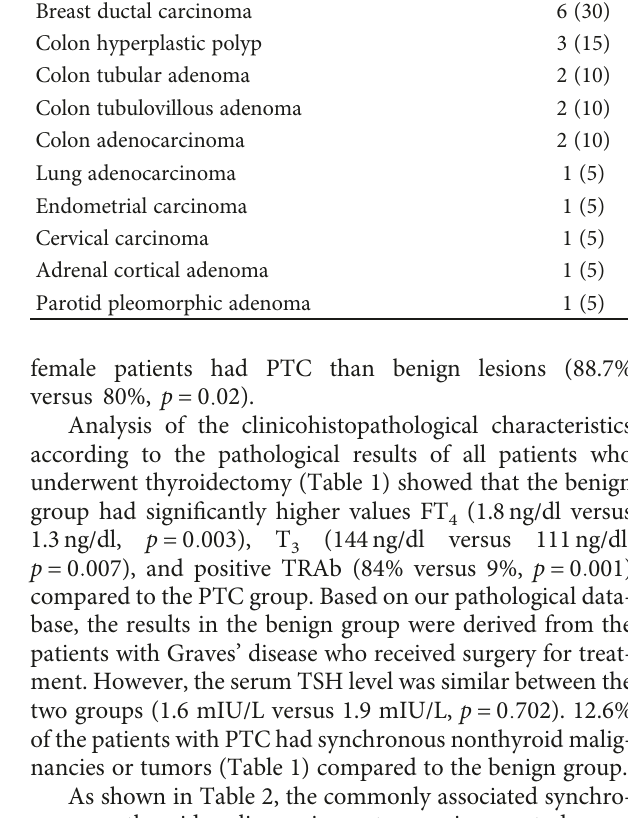
Table 2: List of synchronous nonthyroid malignancies or tumors. Synchronous nonthyroid malignancies or tumors Cases